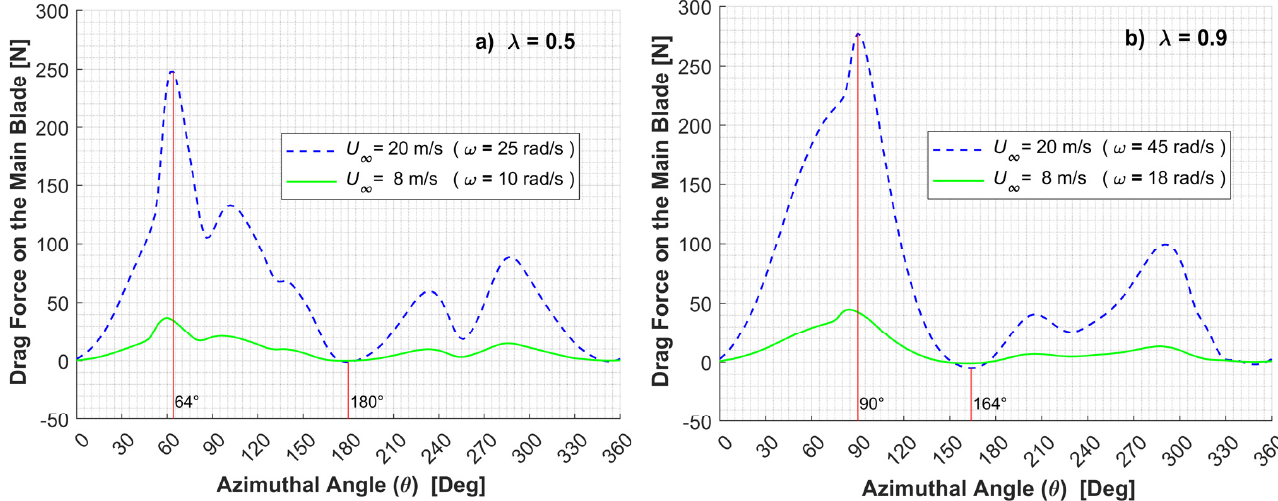
Figure 11. Drag Force for Blade 1at Various Azimuthal Angles, for U ∞ = 8 m/s and U ∞ = 20 m/s at: ( a ) λ = 0.5 and ( b ) λ = 0.9, Using the 2D Model of the Present Study.